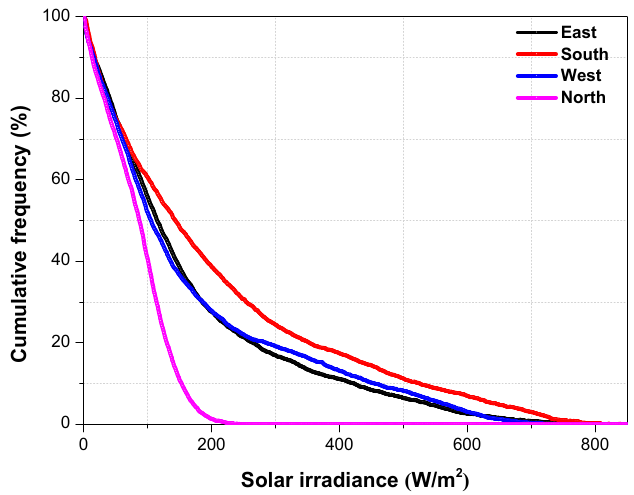
Figure 9. Cumulative frequency of vertical global solar radiation.